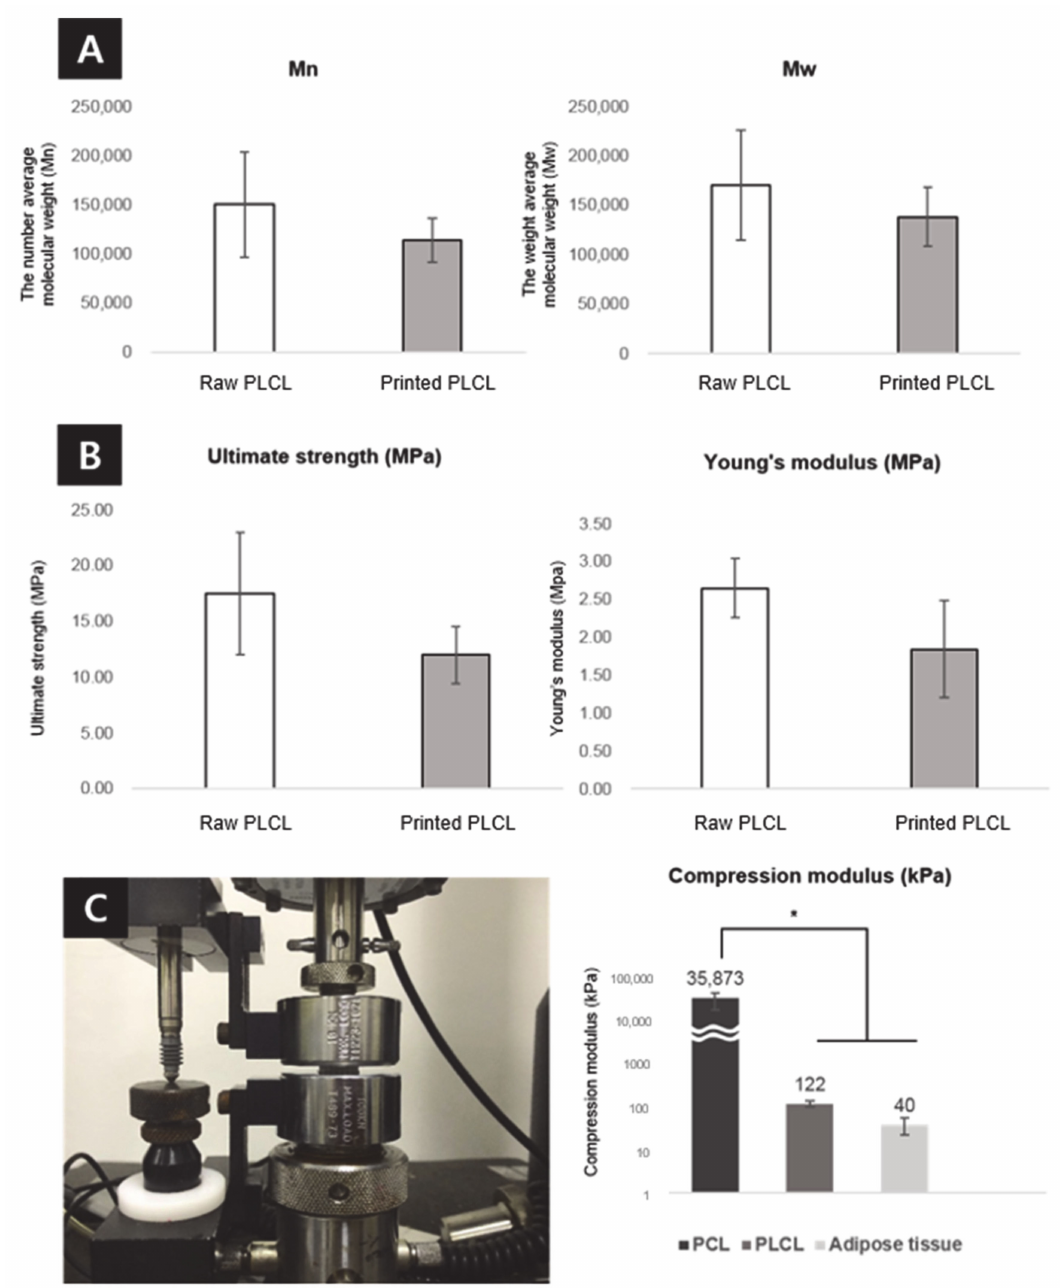
Figure 6. Evaluation of the molecular weight changes and mechanical properties. ( A ) The number (Mn, left) and weight (Mw, right) average molecular weight changes of the PLCL copolymer after 3D printing. Analysis of the mechanical properties of the PLCL copolymer before and after 3D printing, including the ( B ) ultimate strength (left) and Young’s modulus (right). ( C ) Compressive modulus value of the PCL, PLCL scaffolds and adipose tissue was evaluate. All samples were evaluated in triplicate, and the error bar indicates SD (* p <